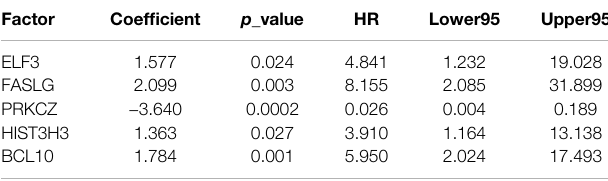
TABLE 1 | Univariate Cox regression results for genes. Factor